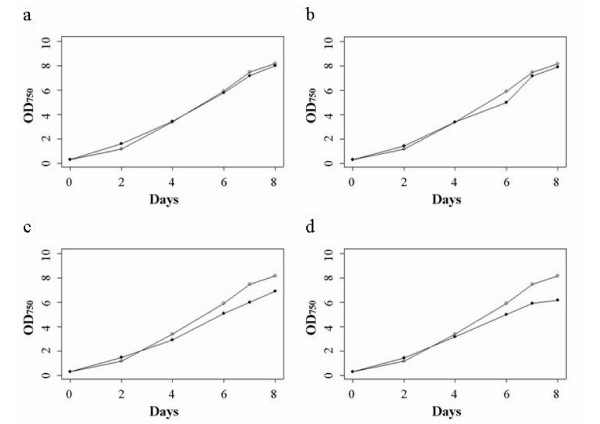
Growth of the sig mutants (solid circle) compared to the wild type strain (open circle) under normal conditions. a: sigB mutant, b: sigC mutant, c: sigD mutant, d: sigE mutant. Wild type and mutant strains were grown in Bg11 medium. Growth was monitored by measuring the optical density at 750 nm (A750).